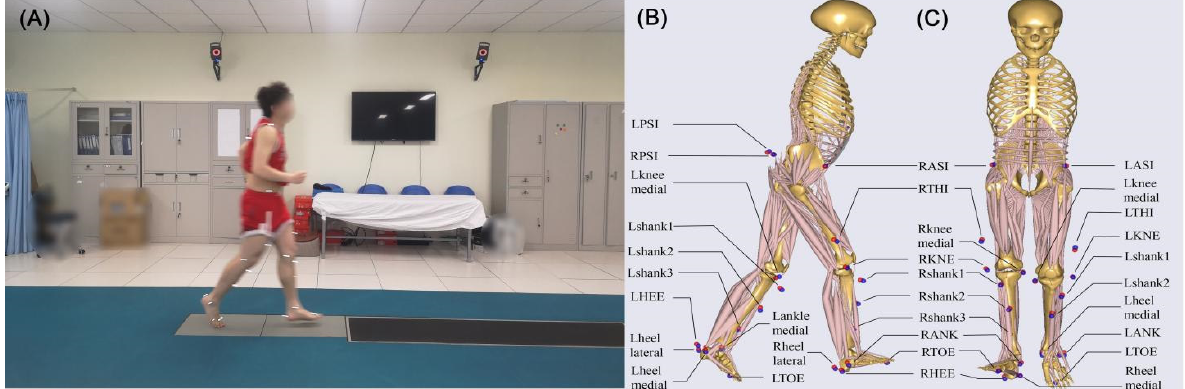
Figure 1. ( A ) Experimental data collection diagram; ( B ) The side view and ( C ) the front view of locations and names of the designated (red)/experimental (blue) markers on the musculoskeletal model when performing inverse dynamic analysis.